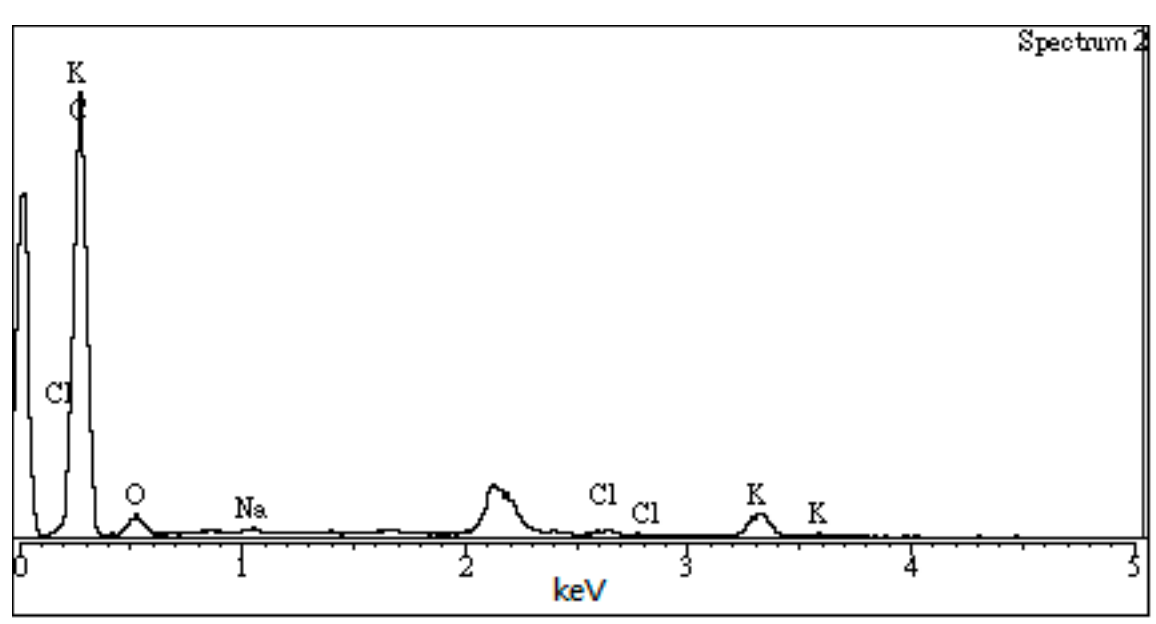
Figure 3. SEM images (( a ) Left: ×1000; ( b ) Right: ×3000) of resulting AC (WCH-AC).